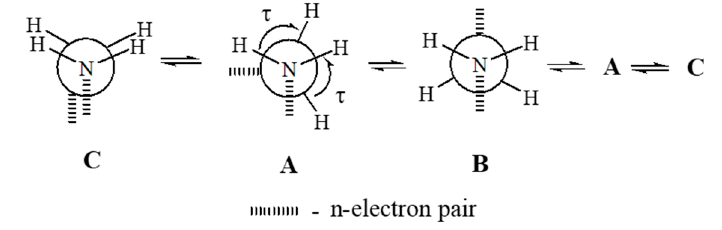
Figure11. DifferencesintheenergyofHOMO-LUMOofdialane(PBE / 3 ζ ). Adaptedwithmodification[178]. Figure 11. Differences in the energy of HOMO-LUMO of dialane (PBE/3 ζ ). Adapted with modification [178].